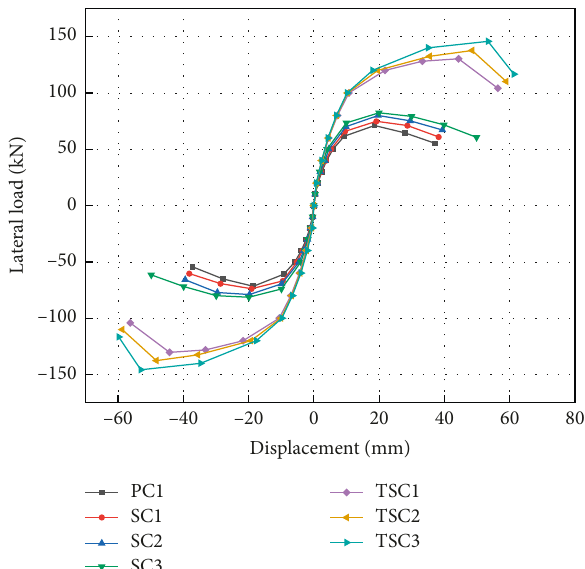
Figure 8: Skeleton curves of the seven specimens.